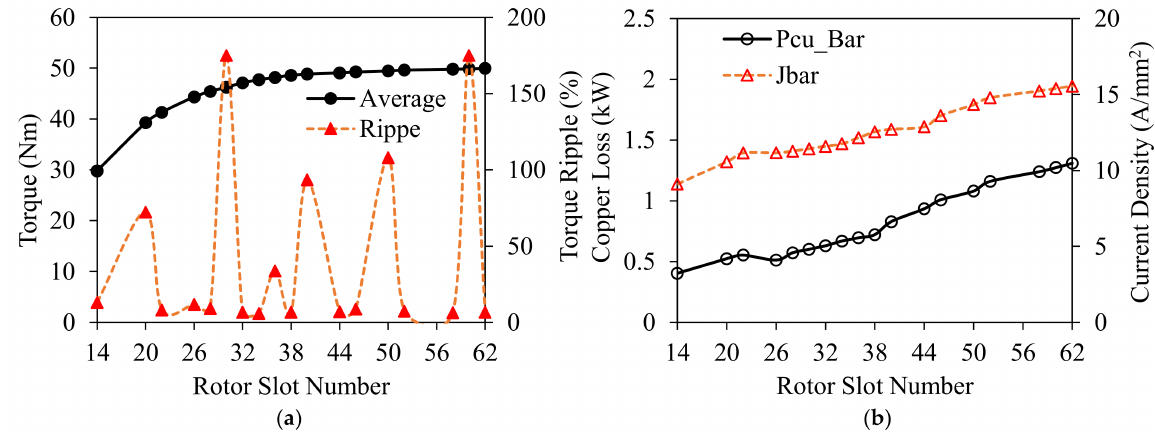
Figure 25. Influence of the rotor slot number on the performance characteristics of 30S/10P AIM: ( a ) torque and torque ripple and ( b ) bar copper loss and bar current